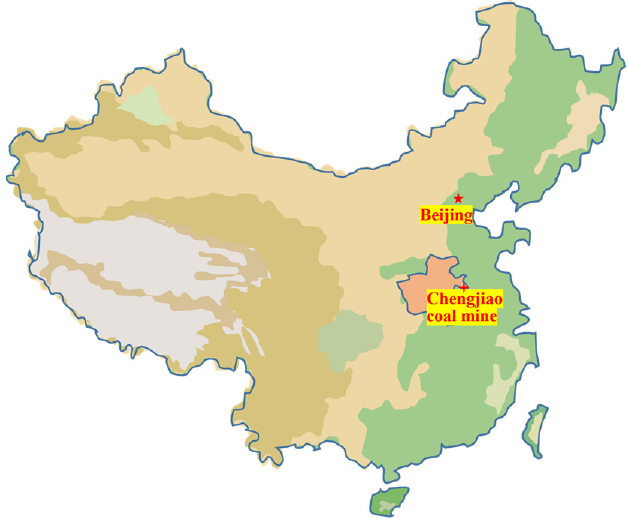
Figure 3. Location of Chengjiao coal mine.